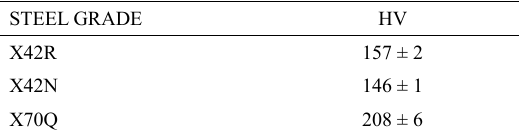
Table 3. Vickers Hardness (HV10) of the studied steels.